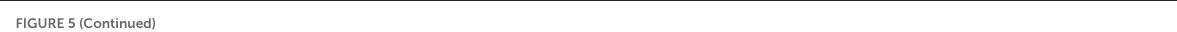
FIGURE5(Continued) The chromatograms show the absorbance at 210nm, plotted against the molecular weight (estimated from the retention times observed with a set of standards). These results were obtained digesta samples collected during semi-dynamic digestions comprising gastric phase (t0 to t150) and three intestinal phases (E1, E2 and E3) conducted on gastric digesta emptied at three times points (50, 100 and 150min). The left section presents results obtained with bread, pasta and breakfast cereal. The right section corresponds to digestion of the same in the presence of a commercial supplemental enzyme mix. Each curve was drawn from the averaged results of three